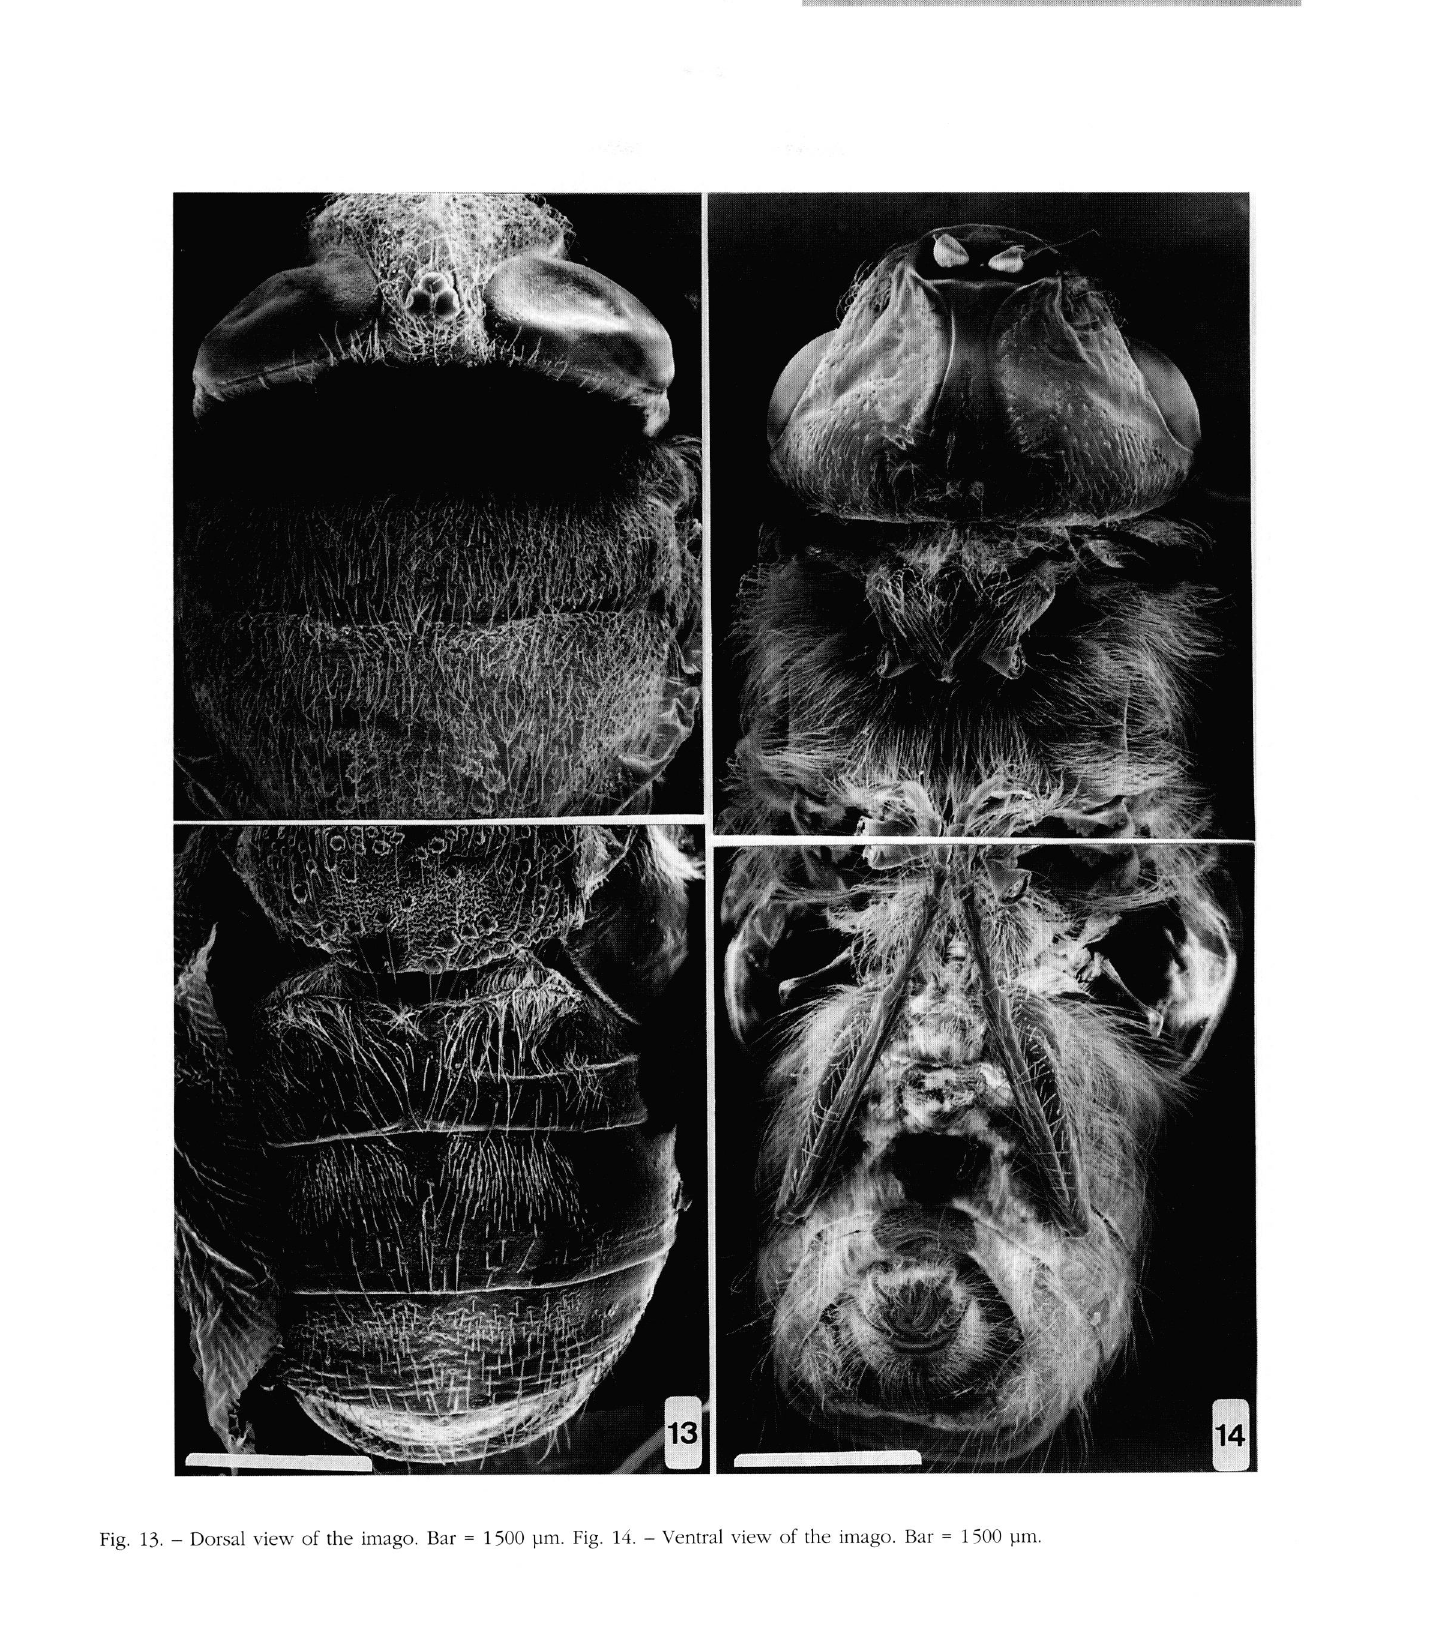
Fig. 13. - Dorsal view of the imago. Bar = 1500 pm. Fig. 14. - Ventral view of the imago. Bar = 1500